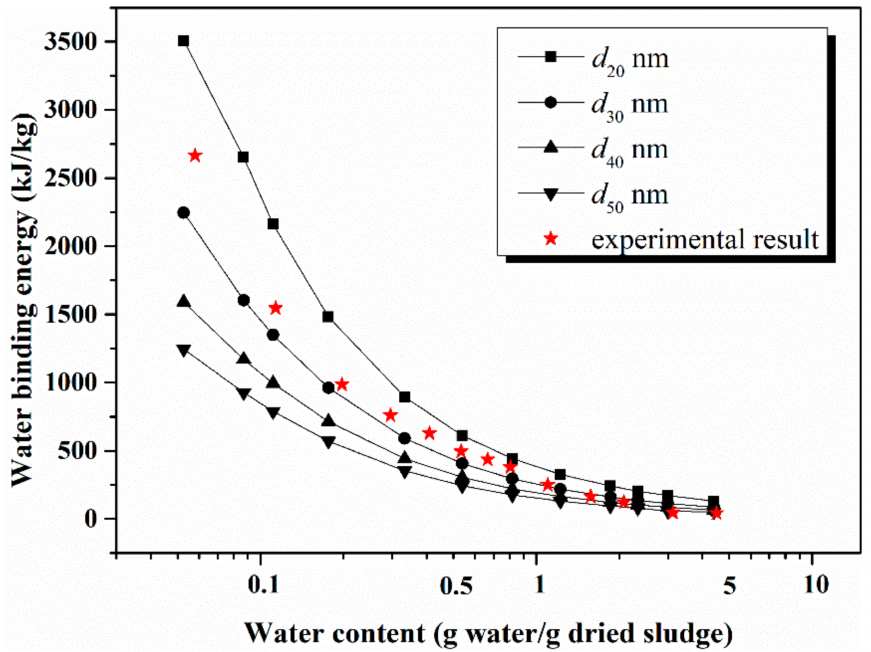
Figure 3. Experimental and model results for the HZ